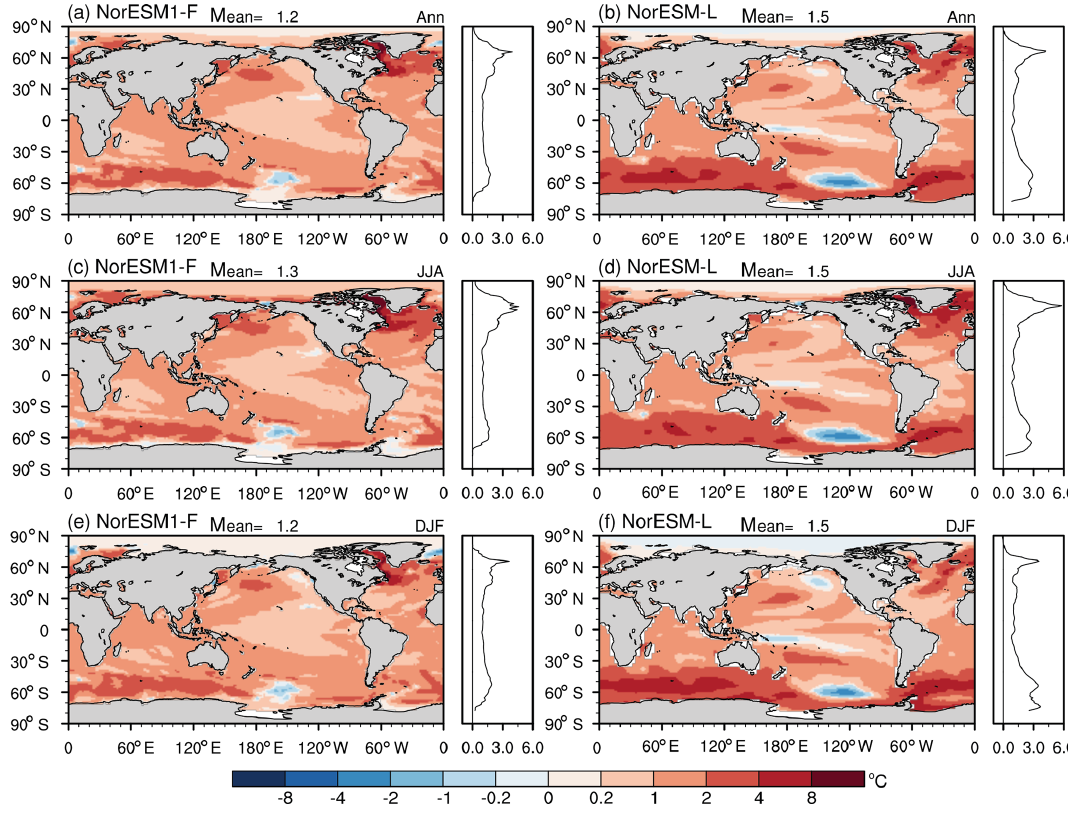
Figure 3. Same as Fig. 1 but for sea surface temperature (units: ◦ C). Table 4. Meridional overturning circulation in the Atlantic Ocean (AMOC) and the Pacific and Indian oceans (PMOC). Meridional overturning circulation NorESM1-F NorESM-L PI